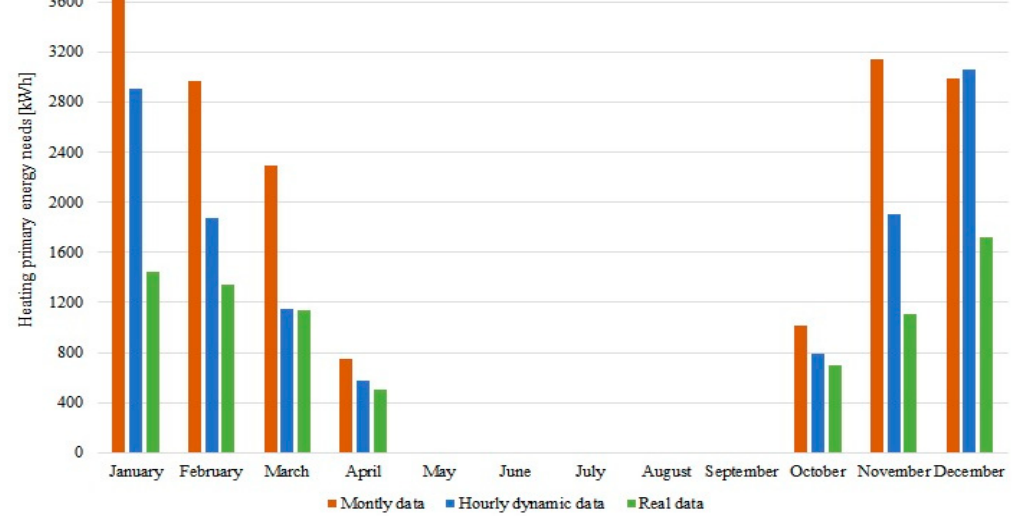
Figure 4. Hourly dynamic, monthly semi-stationary calculated data and real primary energy needs.